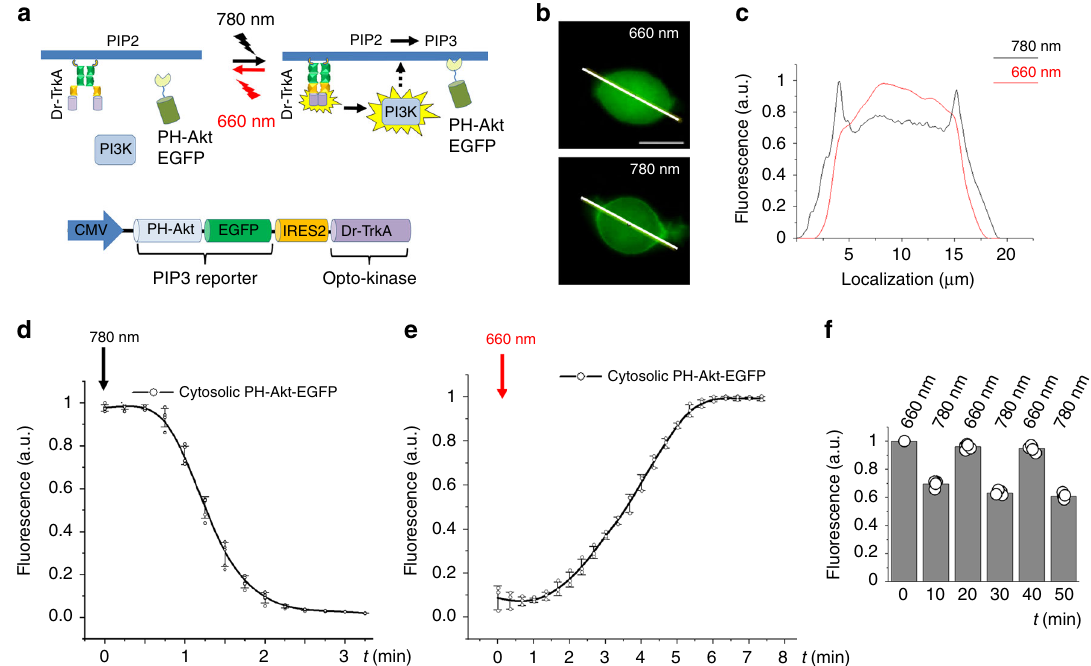
Fig. 4 Light-dependent translocation of PH-Akt-EGFP reporter in PC6-3 cells. a Top: Dr-TrkA is inactive in cells kept under 660 nm light. The 780 nm light causes activation of the Dr-TrkA and downstream phosphatidylinositol triphosphate (PIP3) kinase. This results in accumulation of PIP3 in the plasma membrane and recruiting of PH-Akt-EGFP reporter from the cytoplasm. Bottom: Schematic drawing of the bicistronic pPH-Akt-EGFP-IRES2-Dr-TrkA plasmid co-expressing PH-Akt-EGFP and Dr-TrkA. b Top: Epi fl uorescence image of the PC6-3 cell transfected with the bicistronic plasmid and kept under 660 nm light. Bottom: Epi fl uorescence image of the PC6-3 cell kept under 780 nm light for 10 min to reach steady-state Akt transition to the plasma membrane. Scale bar, 10 μ m. c Steady-state intensity pro fi le of PH-EGFP-Akt fl uorescence of the PC6-3 cell kept under 660 nm light (red line) and illuminated by 780 nm light for 10 min (black line). d Relative decrease of cytoplasmic PH-Akt-EGFP fl uorescence induced by 780 nm light (0.5 mW cm − 2 ). e Relative increase of cytoplasmic PH-Akt-EGFP fl uorescence induced by 660 nm light (0.5 mWcm − 2 ). f Reversible translocation of the PH-Akt-EGFP reporter between the plasma membrane and cytoplasm in response to 780 nm and 660 nm illumination. Error bars represent s.d., n = 3